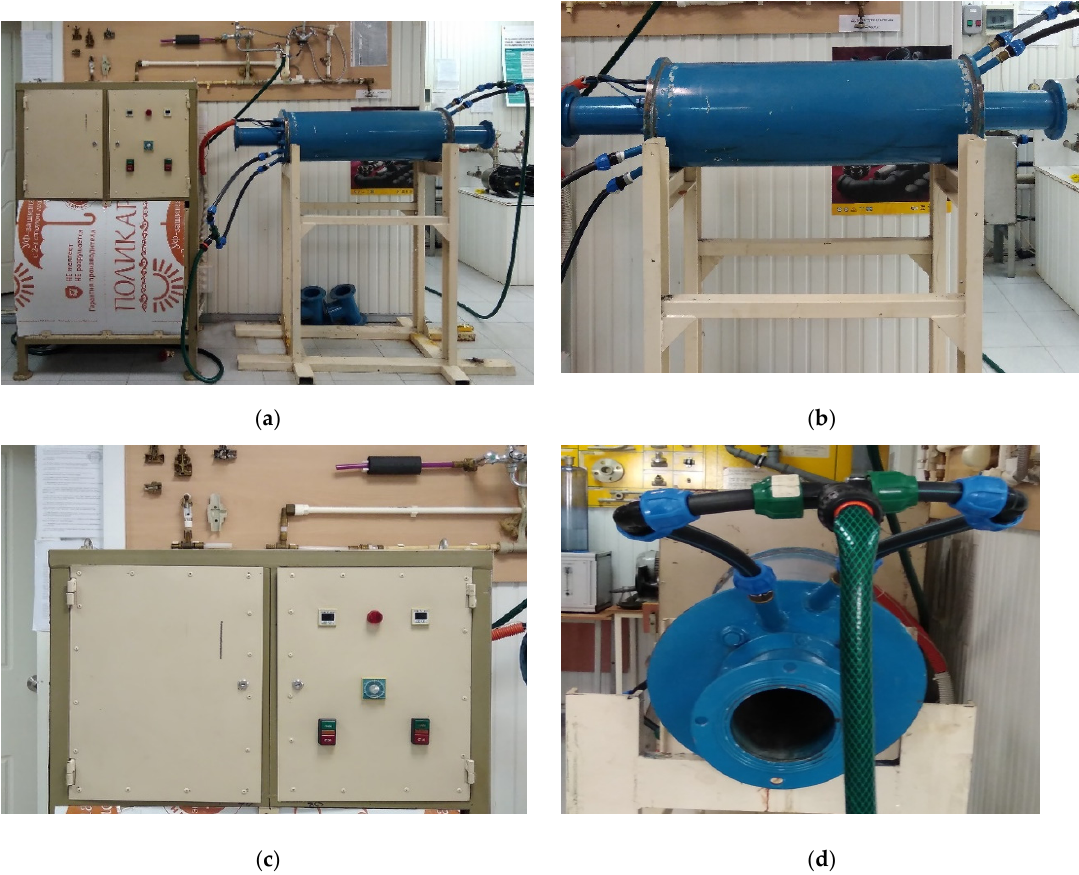
Figure 3. Photo of the process activation unit: ( a ) general view; ( b ) working building; ( c ) control cabinet; ( d ) side view of the working body, feed opening.